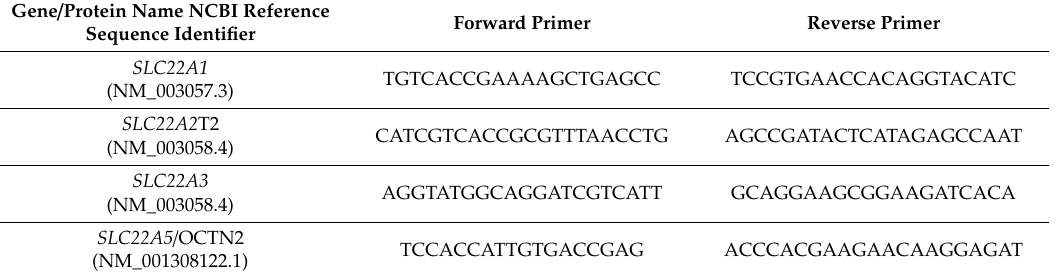
Table 1. Sequences of the primer pairs employed for RT-qPCR